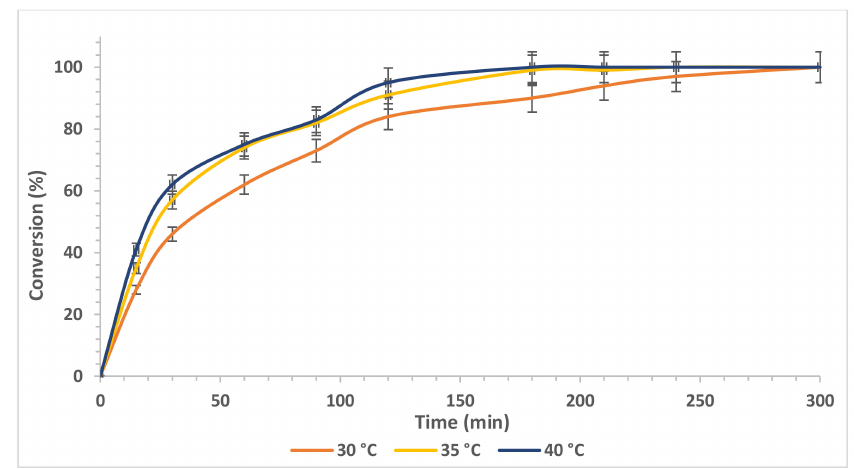
Figure 3. Synthesis of 1e catalysed by PSL in anhydrous THF at different temperatures (30 ◦ C, 35 ◦ C and 40 ◦ C).